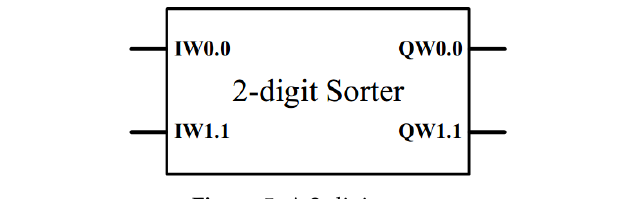
Figure 5. A 2-digit